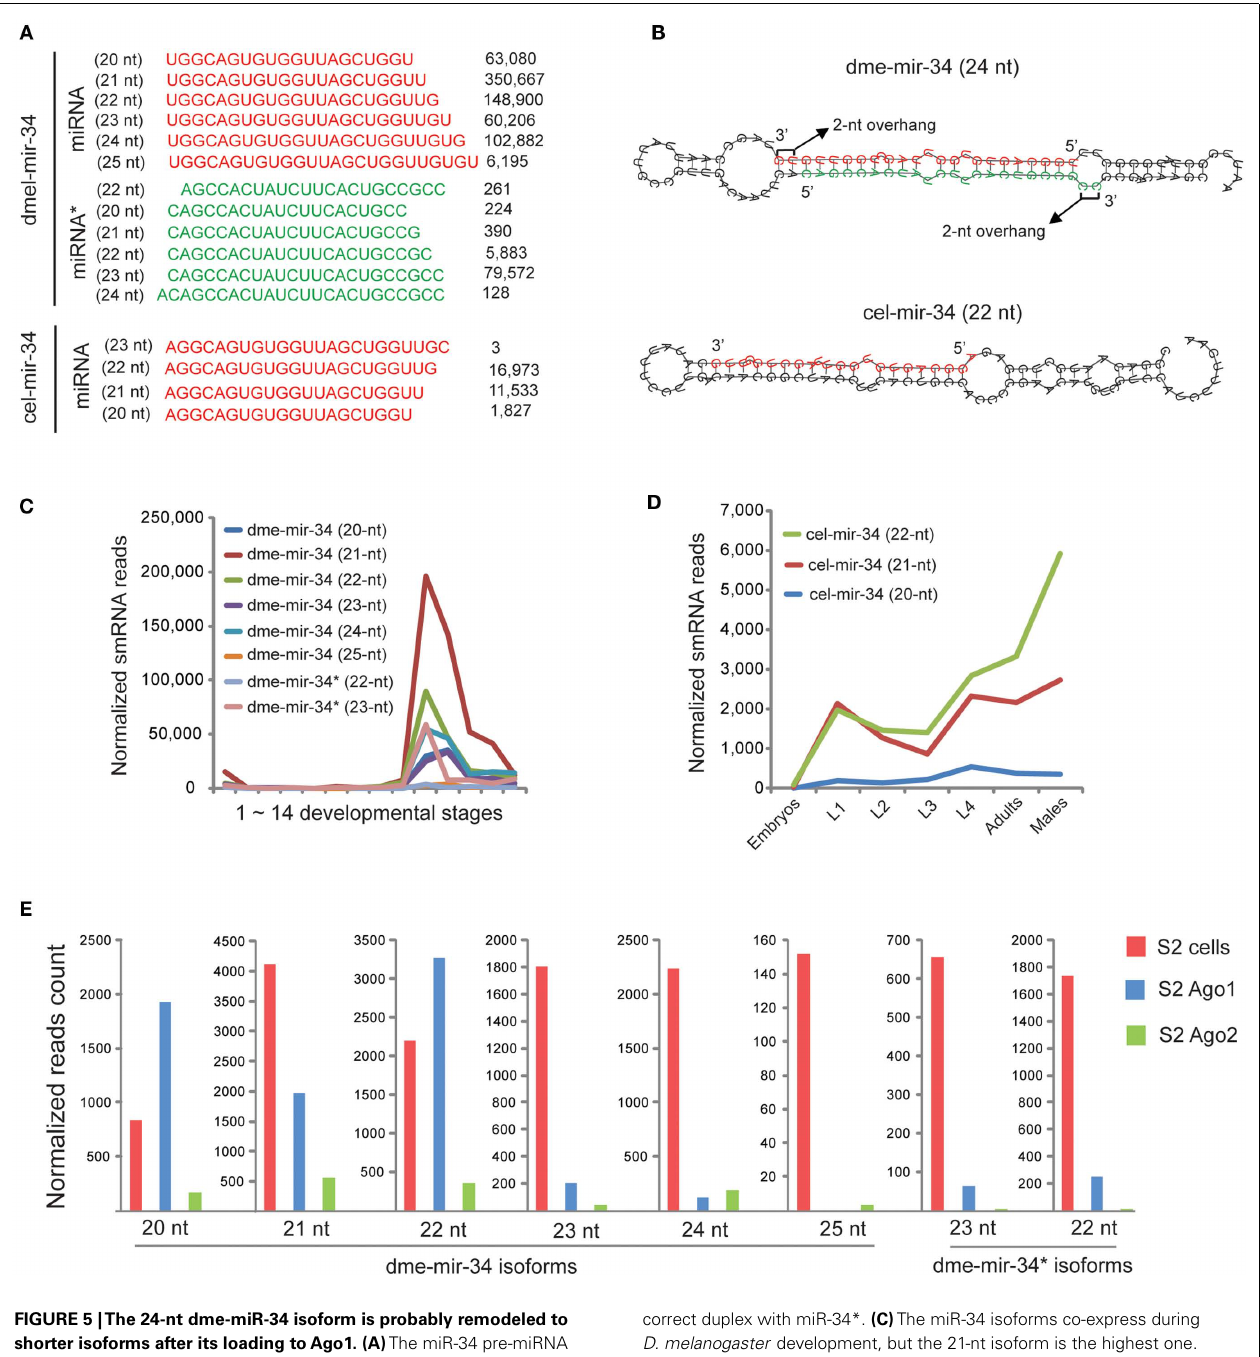
FIGURE 5 |The 24-nt dme-miR-34 isoform is probably remodeled to shorter isoforms after its loading toAgo1. (A) The miR-34 pre-miRNA produces huge amount of miR-34 isoforms in D. melanogaster , and the 24-nt isoform is the miRBase annotated mature sequence. (B) The hairpin structure of dme-mir-34 shows that only the 24-nt isoform can form the